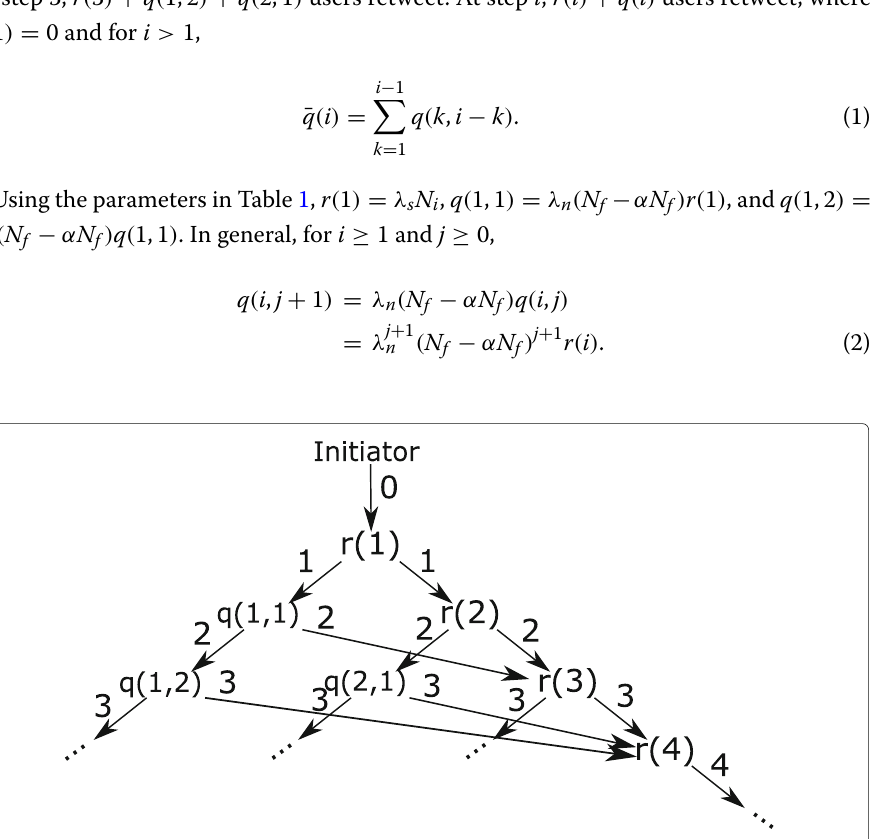
Fig. 1 The arrow from r ( 2 ) to q ( 2,1 ) indicates that after receiving retweets from r ( 2 ) supporters at step 2, q ( 2,1 ) non-supporters post retweets at the next